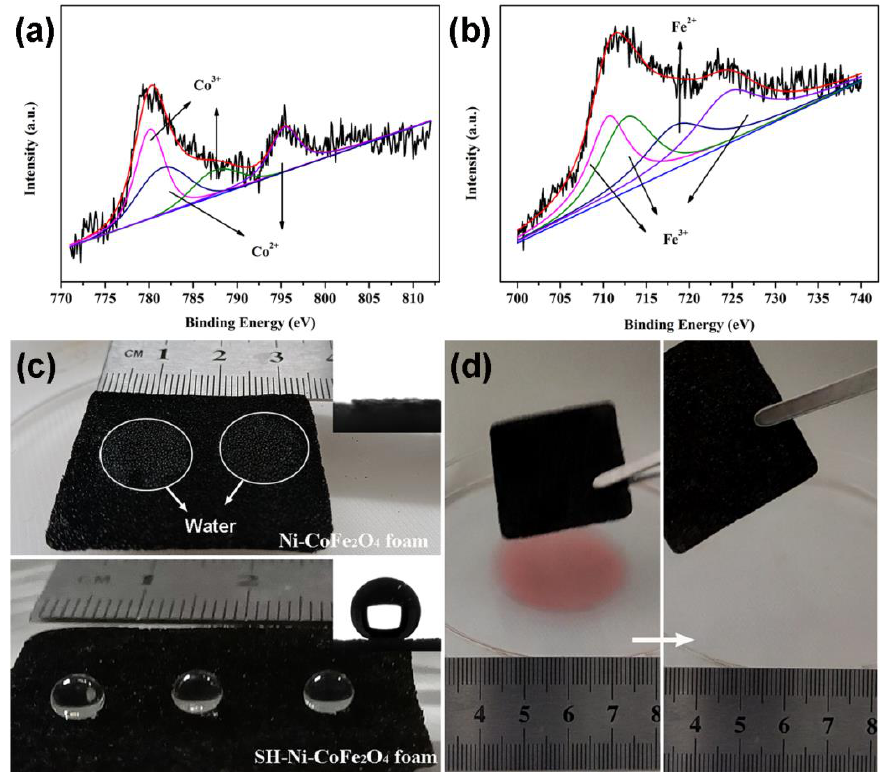
of the Ni-CoFe 2 O 4 foam, showing their superhydrophilicity. The inset shows that the